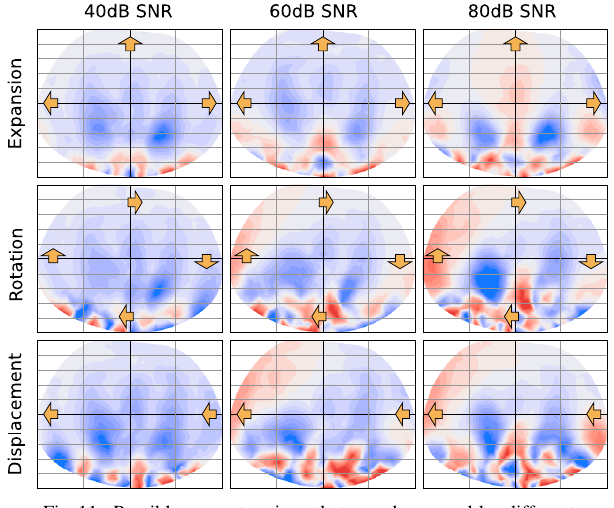
Fig.11: Possible reconstructions that may be caused by different distorsions are illustrated. The rows denote, respectively, the images reconstructed from different body distorsions, i.e., 10% chest expansion, 10 o clockwise rotation and 2 cm right-lateral